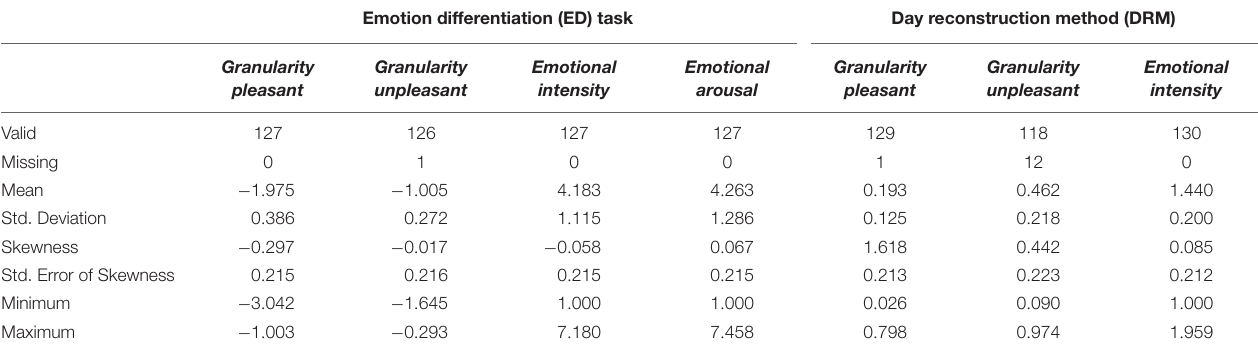
TABLE 3 | The descriptive statistics for the Emotion Differentiation (ED) task and the Day Reconstruction Method (DRM) for emotional arousal, intensity, and granularity scores. Emotion differentiation (ED)